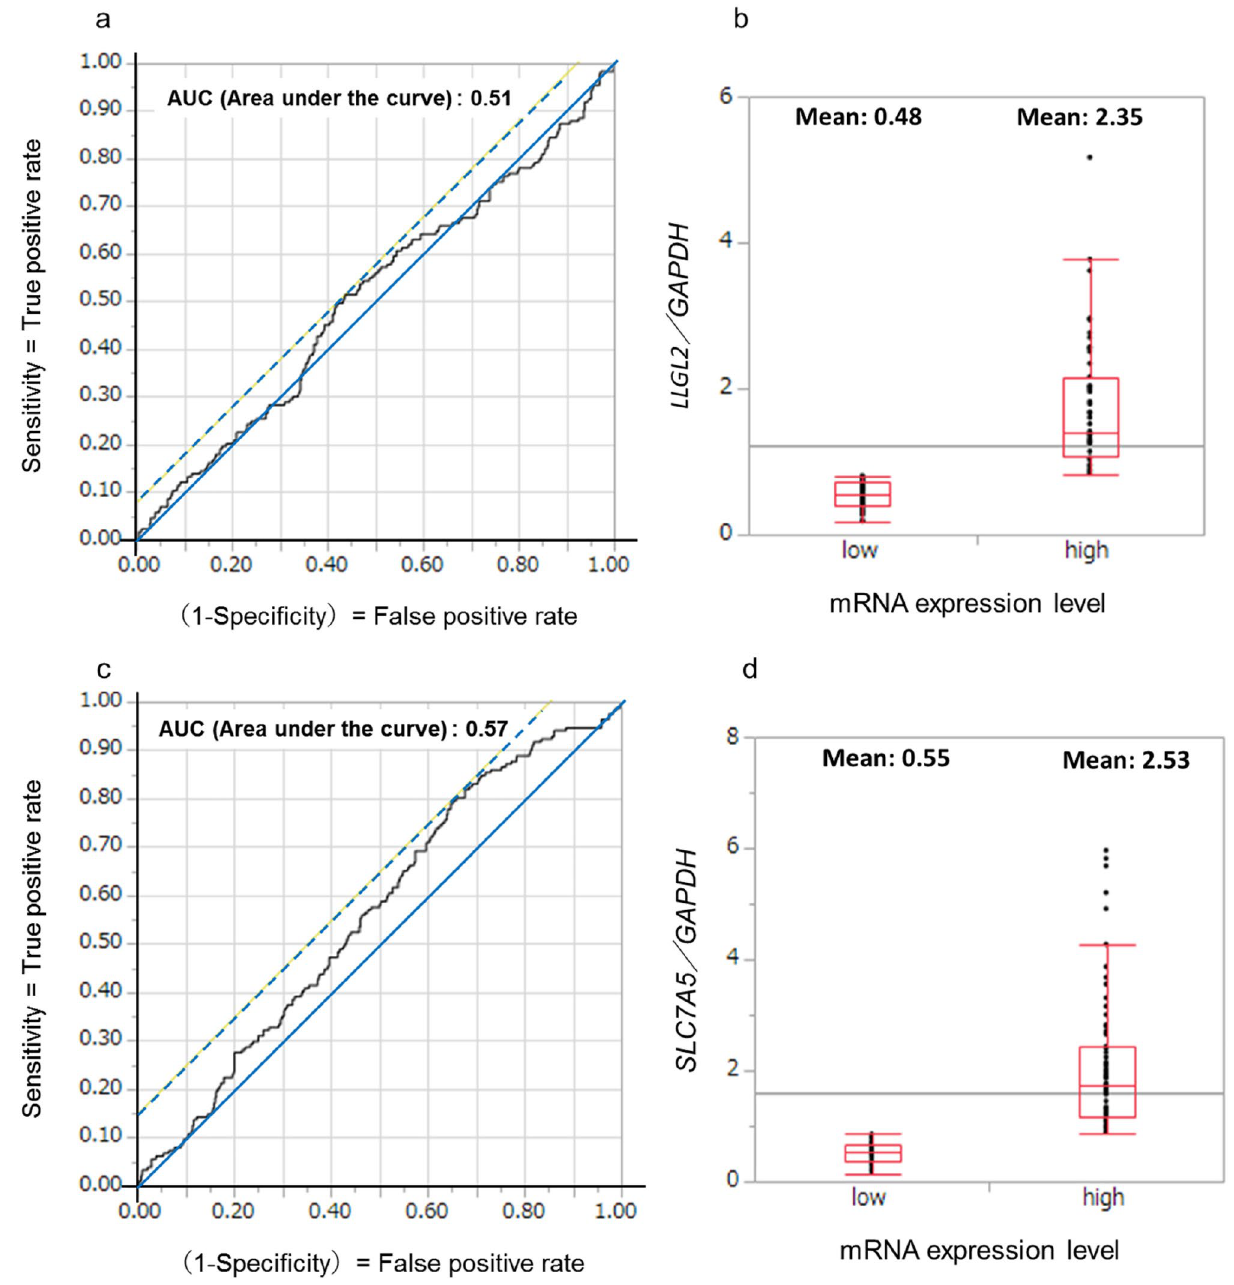
Figure 4. ROC analysis to define the threshold for LLGL2 and quantitative differences in LLGL2 mRNA expression ( a,b ). ROC analysis to define the threshold for SLC7A5 and quantitative differences in SLC7A5 mRNA expression ( c,d